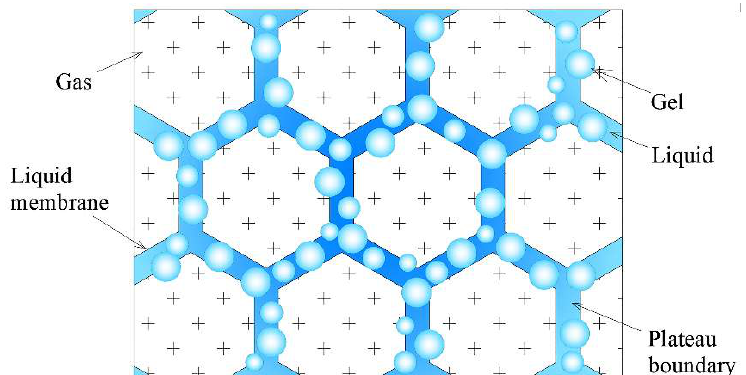
Figure 12. Schematic diagram of foam gel structure.